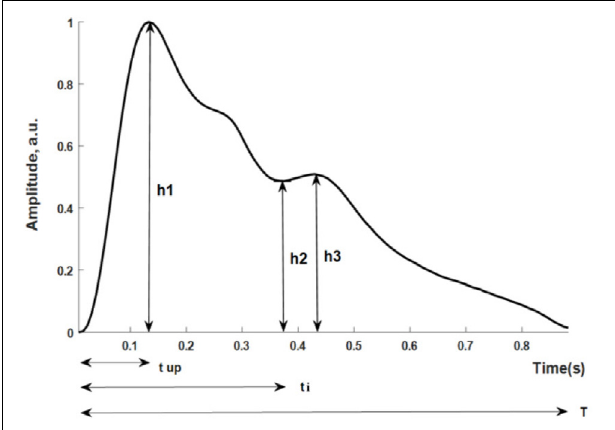
FIGURE 1 | Parameters directly determined from the measured pulse